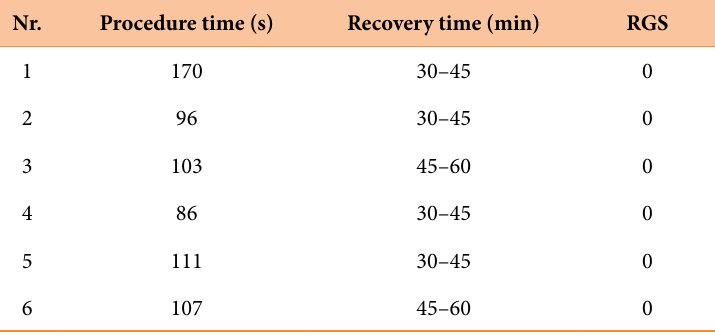
speed, recovery time and postoperative